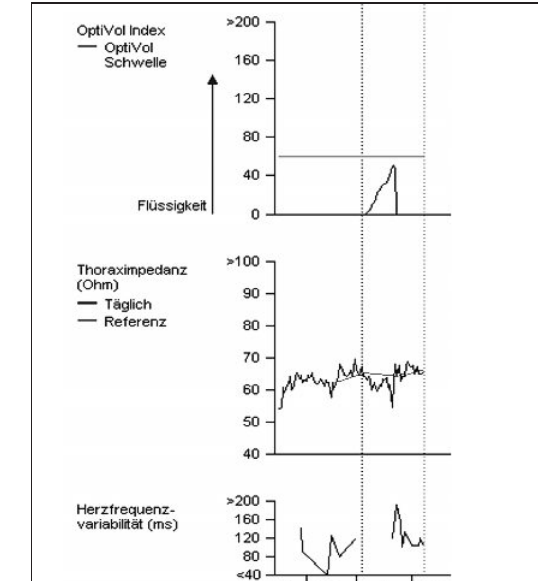
Remotely program- mable alert options